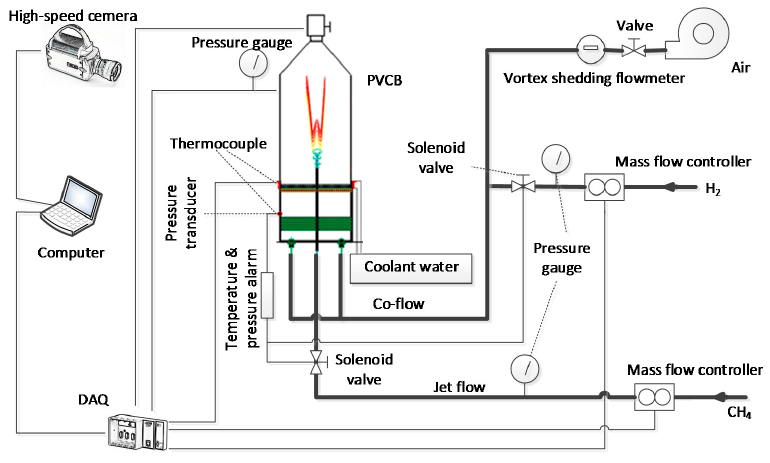
Figure 2. Experiment system of the pressurized vitiated co-flow burner (PVCB).